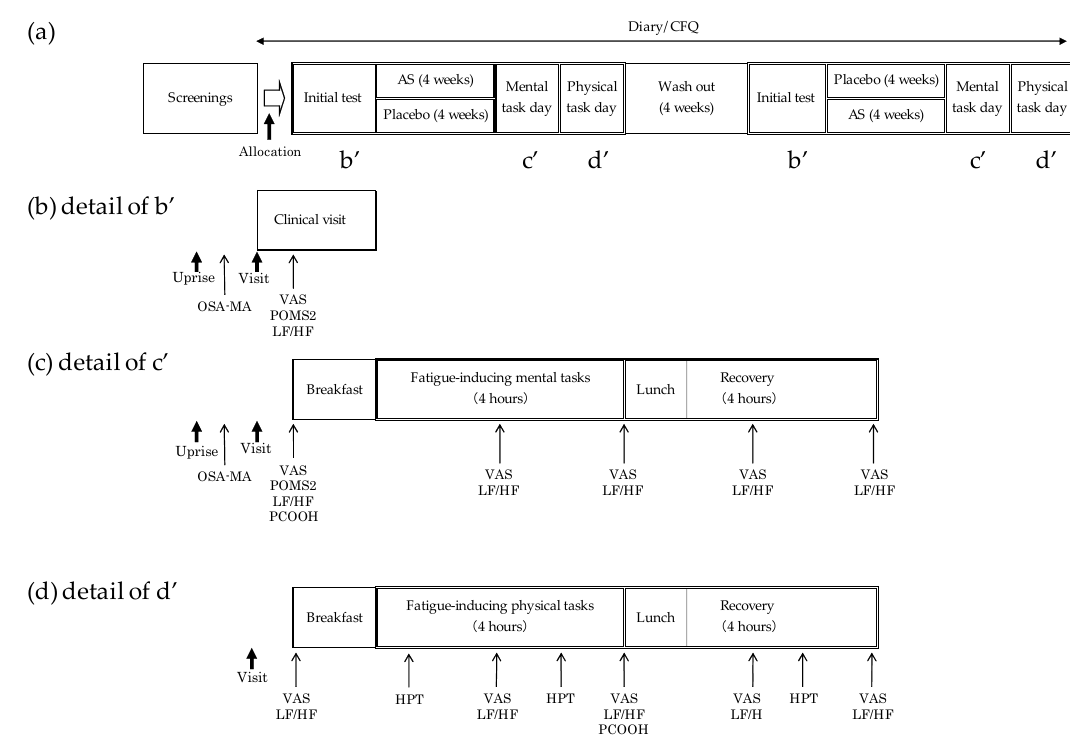
Figure 1. Study design and major evaluation items. ( a ) Study overview; ( b ) schedule of initial test day; ( c ) schedule of mental task day; ( d ) schedule of physical task day.